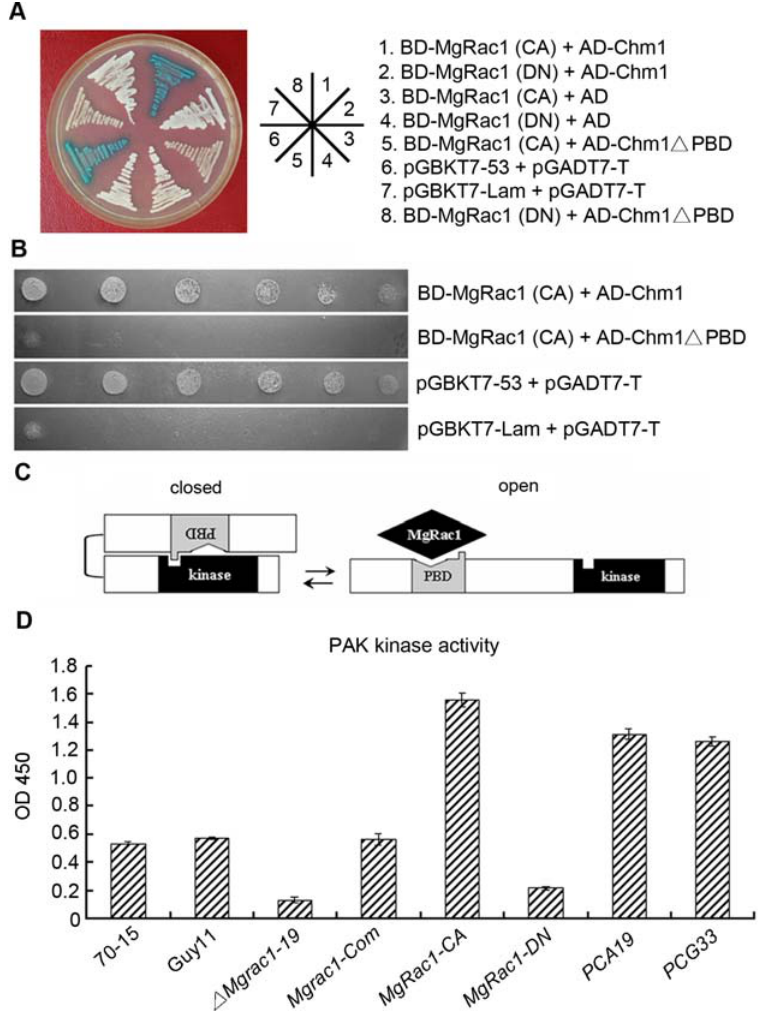
Figure 6. The interaction between MgRac1 and Chm1 or Chm1 D PBD and PAK activity assay. (A) Yeast two-hybrid assay with MgRac1-CA or MgRac1-DN as the bait and Chm1 or Chm1 D PBD as the prey. Yeast transformants grown on the SD-Leu-Trp plates were assayed for b - galactosidase activity. The interaction of pGBKT7-53 and pGADT7-T was used as the positive control. The interaction of BD-MgRac1(CA) or BD- MgRac1(DN) and AD (pGADT7) was used as the negative control to rule out self-activation. (B) The indicated yeast transformants diluted to specified concentrations (cell/ml) were plated onto SD-Ade-Leu-Trp-His to examine the HIS3 reporter gene expression in the yeast two-hybrid assay. The interaction of pGBKT7-Lam and pGADT7-T was used as the negative control. (C) Model of Chm1 activation and its auto-inhibition by the PBD domain. It involves transition between low-activity (closed) and high-activity (open) conformations. The PBD domain (grey) contains domains that bind MgRac1 and the PAK kinase domain, as indicated. (D) PAK kinase assay showing correlation of MgRac1 and PAK activity in the hyphae of WT and mutants. Total protein preparations were subjected to the kinase assay, which used the HTScan PAK1 kinase assay kit for direct ELISA detection of the product at the absorbance of 450 nm. Means and standard deviation calculated from three replicates were shown on the bar